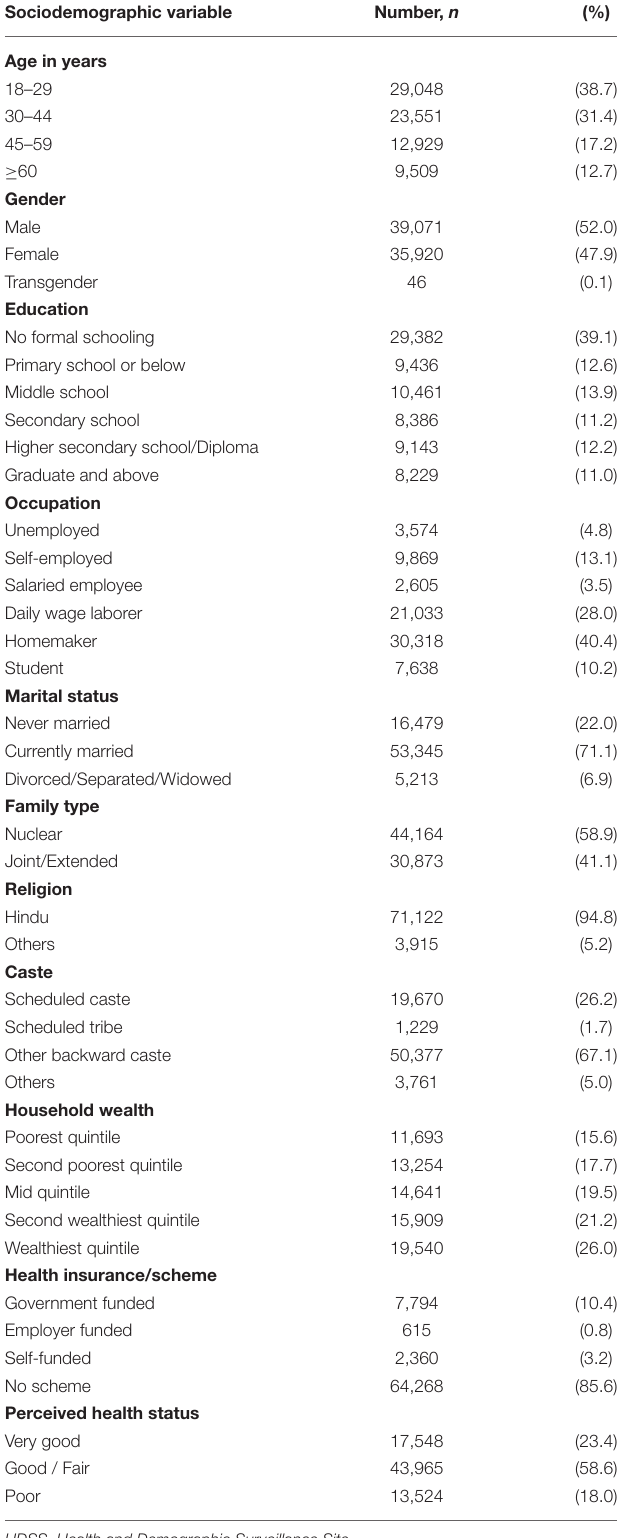
TABLE 1 | Details of sociodemographic characteristics of adults residing in HDSS, Gorakhpur ( N = 75,037). Sociodemographic